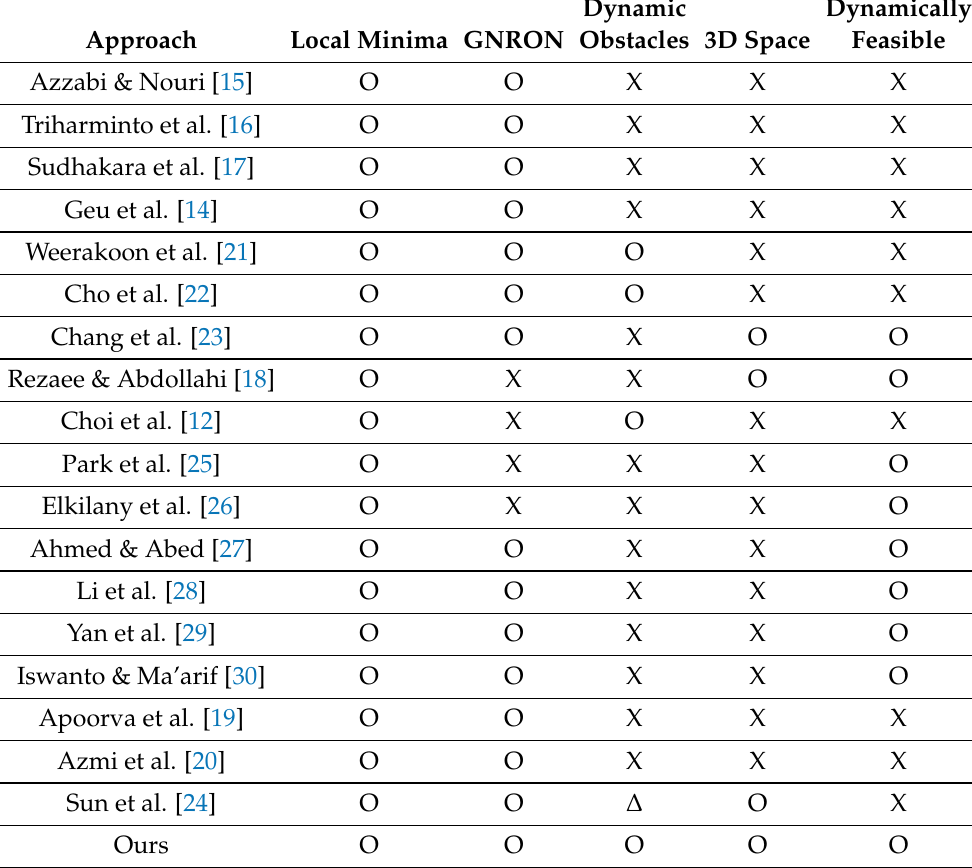
Table 1. A comparison of the collision avoidance (CA) approaches using the artificial potential field (APF) (O: Solved, X: Unsolved, and ∆ : Limited case only). Approach Local Minima GNRON